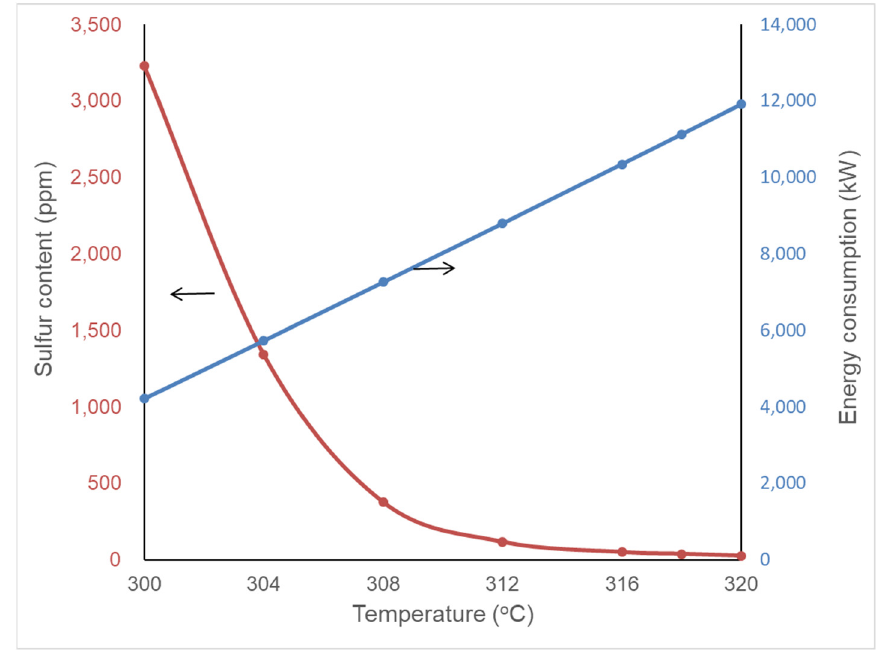
Figure 3. Effect of reaction temperature (reaction pressure 7.7 MPa).